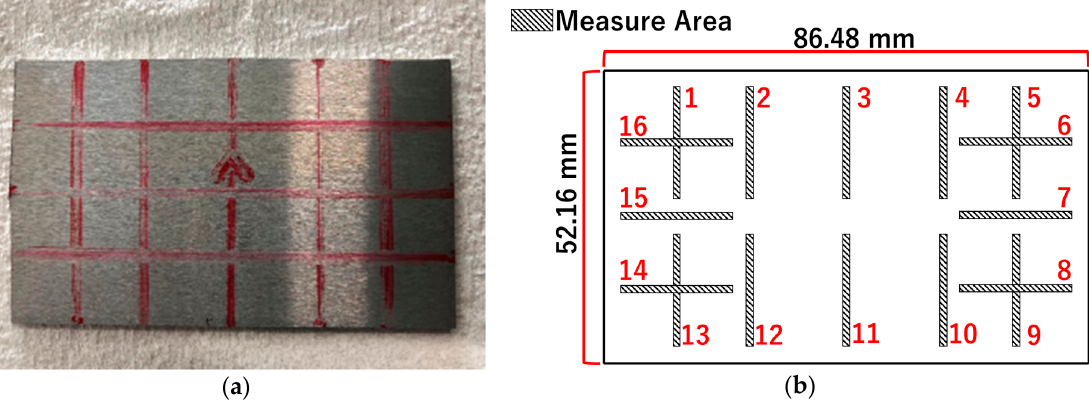
Figure 6. Thickness measurement: ( a ) physical image of the test piece; ( b ) locations of the measured points. The measured thickness data at different locations are summarized in Table 1. Table 1. Thickness measurement data.